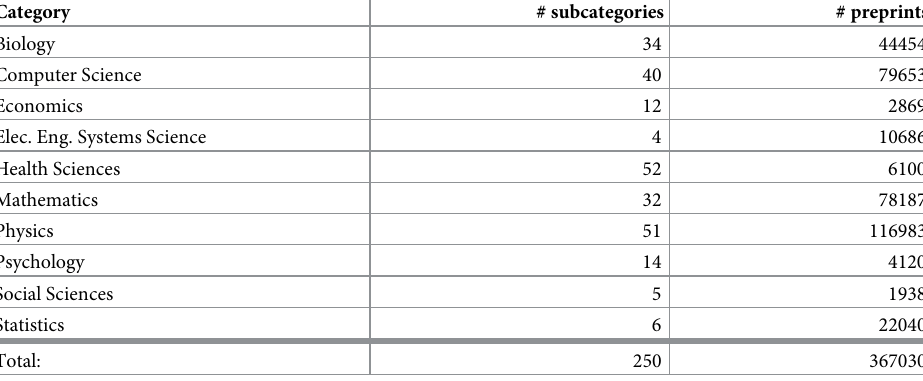
Table 1. Number of subcategories and preprints per category after pre-processing. In the arXiv repository, preprints are sometimes cross-tagged in several categories. As a result, the number of unique preprints is